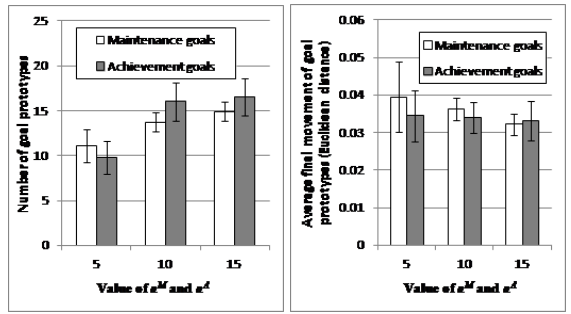
Figure 18: Expt 5: Impact of maximum age on number of goals (left) and convergence of cluster prototypes